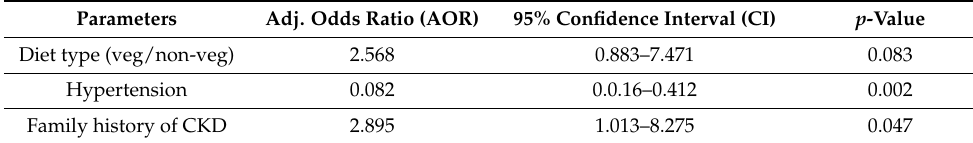
Table 7. Multivariable logistic regression to identify the risk factors for CKD